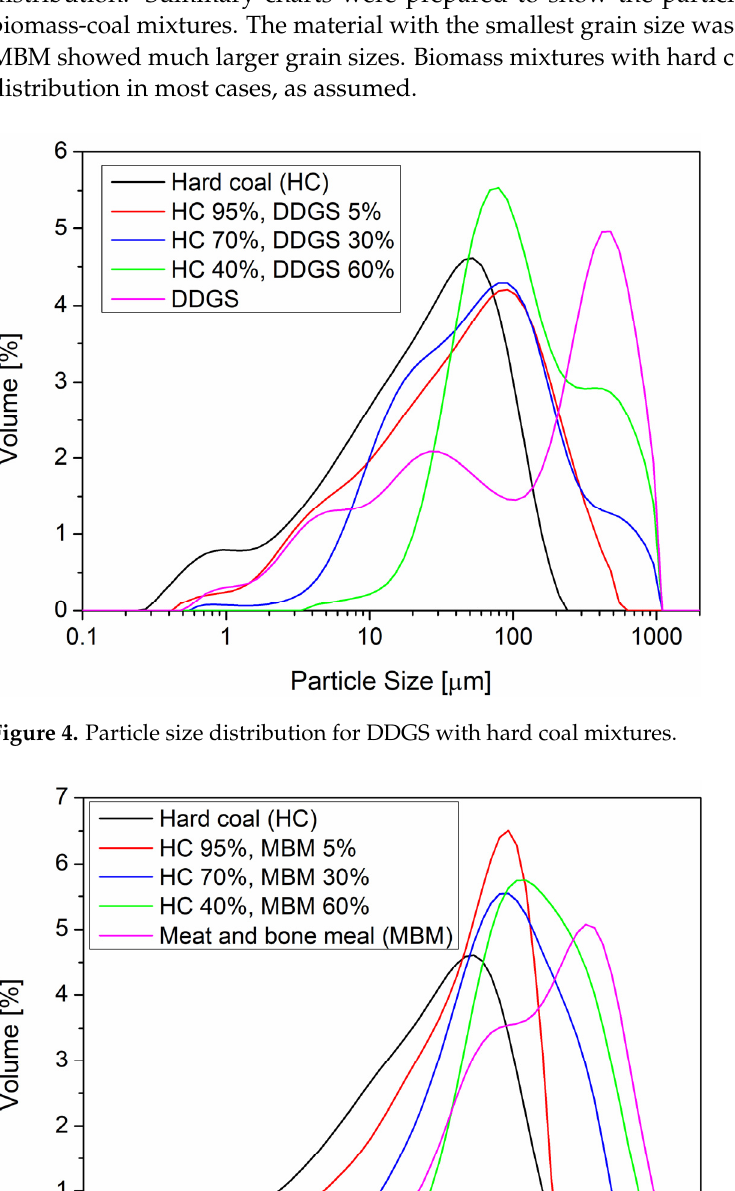
Figure 3. Pictures of the tested materials: ( a ) DDGS; ( b ) MBM.